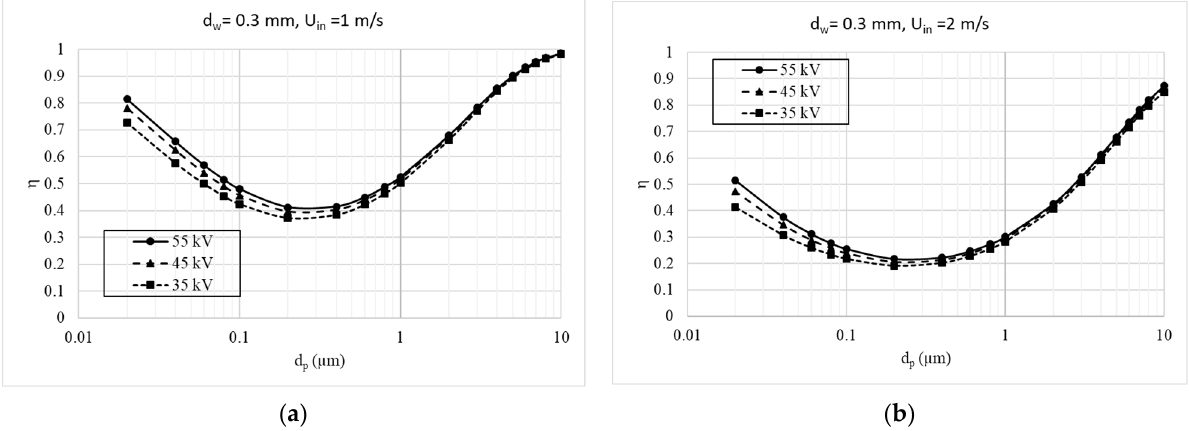
Figure 15. Variation of the ESP collection efficiency with particle diameter for S y = 90 mm, d w = 0.3 mm, ( a ) U in = 1 m/s, ( b ) U in = 2 m/s.